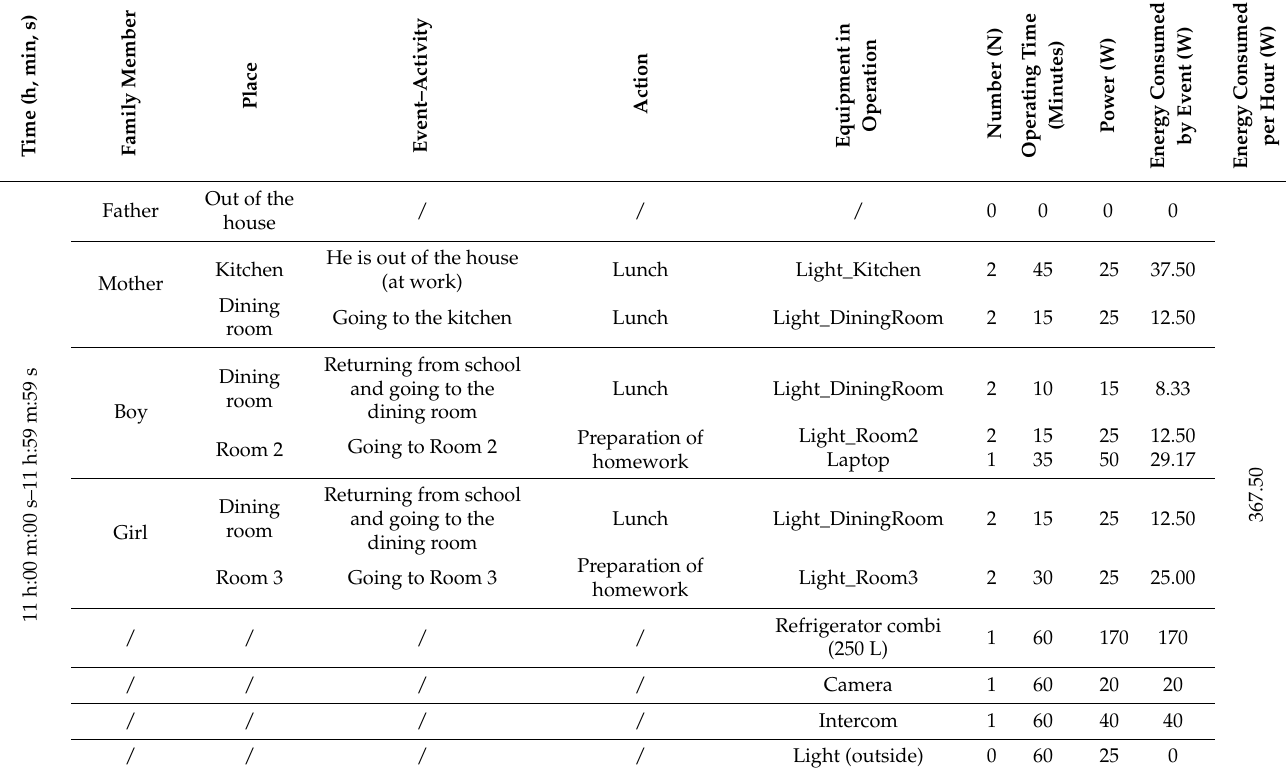
Table 8. Energy consumption scenario in the period: 11 h: 00 m: 00 s to 11 h: 59 m: 59